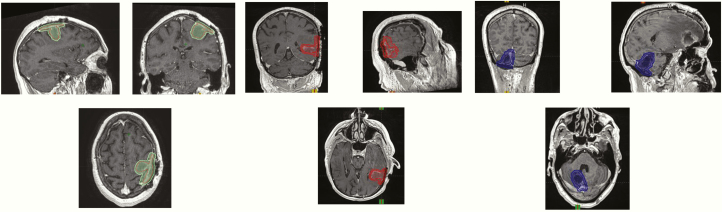
Postoperative cavity radiosurgery contouring guidelines. The complete contouring guideline may be found in the supplementary material and is also found along with the CTSU website materials for the Alliance trial A071801.